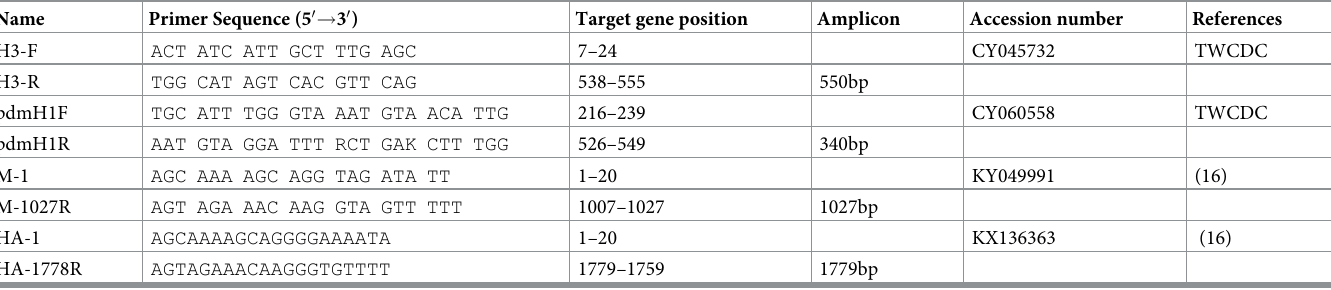
Table 2. Primer sequences of the RT-PCR for HA subtyping and HA gene and MA gene-sequencing